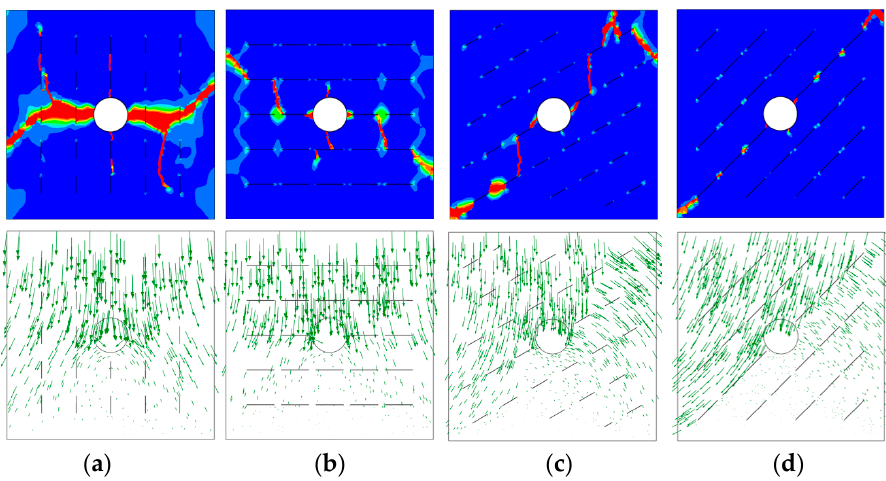
Figure 29. Damage ω 0 and displacement vector at the final step in the four typical specimens with different failure modes. ( a ) HC90 (Mode I); ( b ) HD0 (Mode II); ( c ) HC30 (Mode III); ( d ) HD45 (Mode IV).